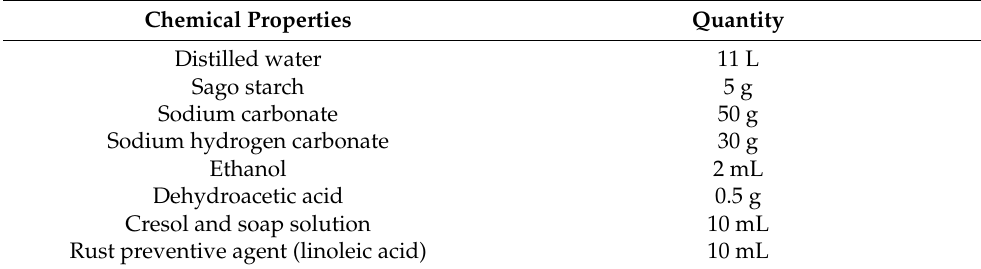
Table 3. Chemical ingredients to prepare the water-soluble sago starch cutting